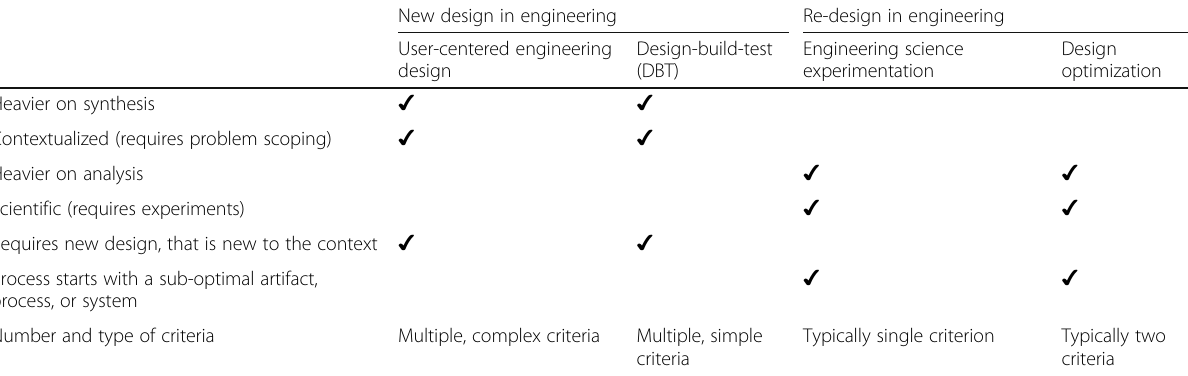
Table 3 Engineering-science integration